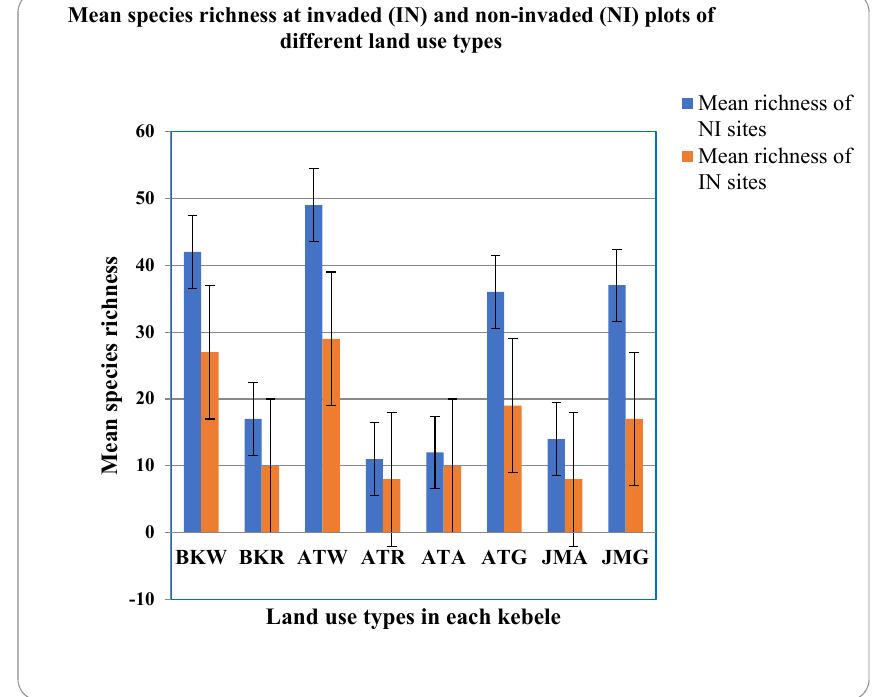
Figure 3. Comparison of species richness at invaded and non-invaded plots of different land use types. ATA—Ardatare Abandoned Agricultural land study side, ATW—Ardatare Woodland land